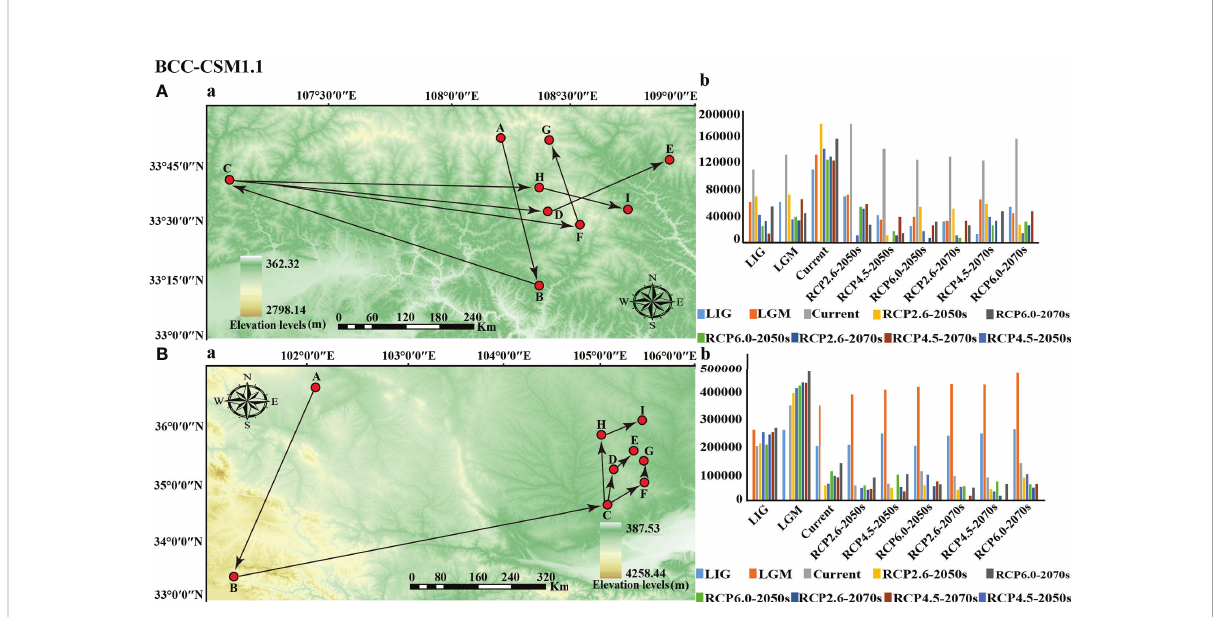
FIGURE 8 Migration of the center of suitable habitat for two subspecies of P . rockii since the last interglacial period ( A : P . rockii subsp. rockii ; B : P . rockii subsp. taibaishanica ; (a) migration route; (b) migration distance). Among them, the meaning of the letters were (A) LIG, (B) LGM, (C) current, (D) RCP2.6-2050s, (E) RCP2.6-2070s, (F) RCP4.5-2050s, (G) RCP4.5-2070s, (H) RCP6.0-2050s, (I)